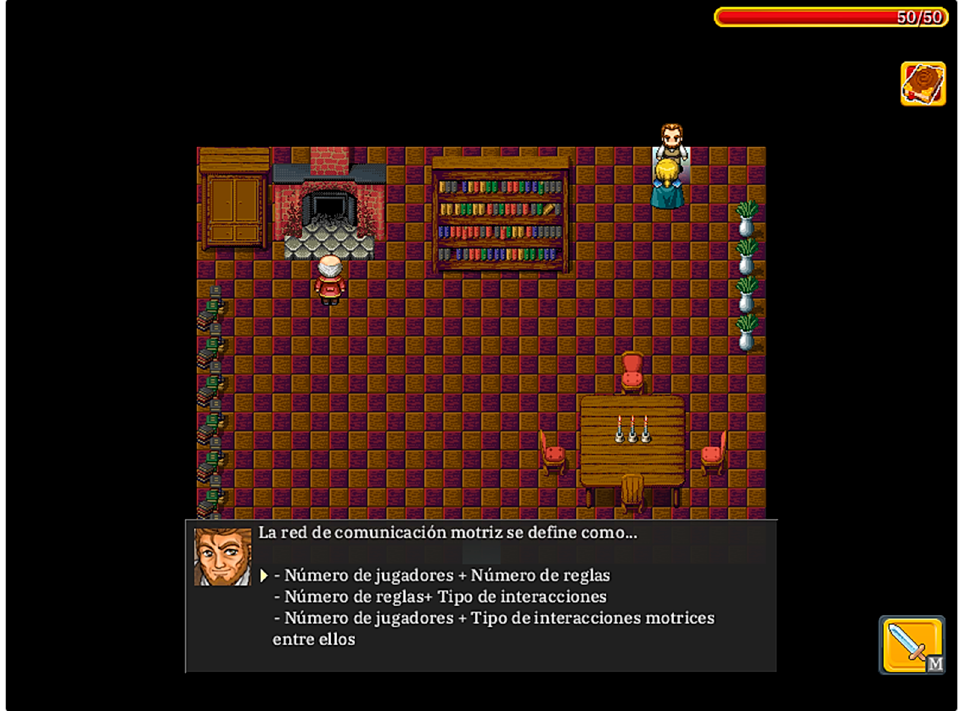
Figure 2. Activity role-playing videogame of the content ‘Motor Communication’.